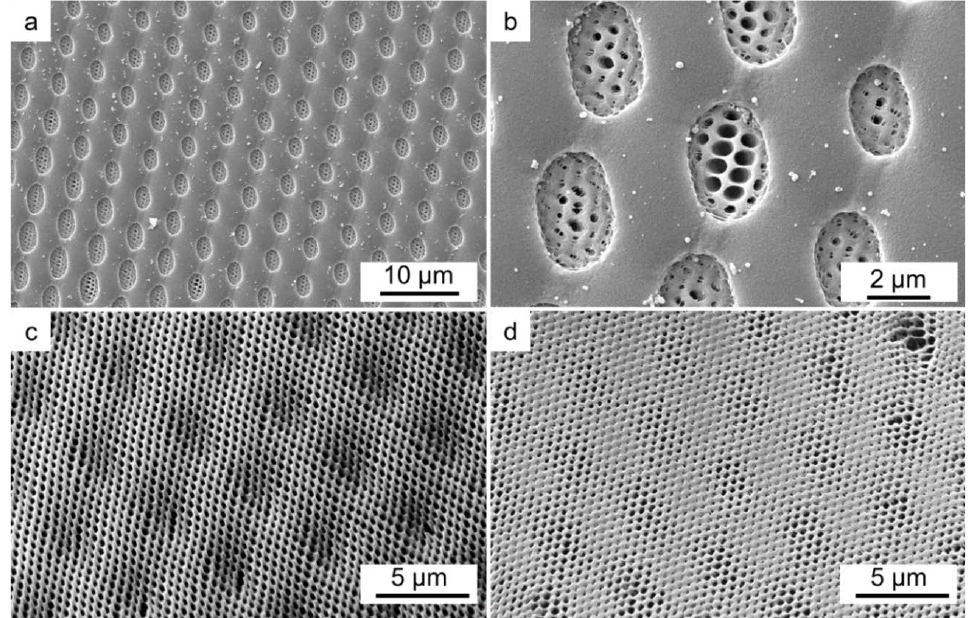
Figure 1. SEM images of ( a ) 5 µm hexagonal hole-like structure on top of a 0.5 µm hole-like structure, ( b ) the same with a larger magnification. ( c ) 5 µm hole-like structure covered with 0.5 µm of spatial period pattern and ( d ) 5 µm and 0.5 µm exposure consecutively in the same layer. In all cases, 7.5 mJ/cm² and 4 mJ/cm² were used for the 5 and 0.5 µm pattern, respectively.